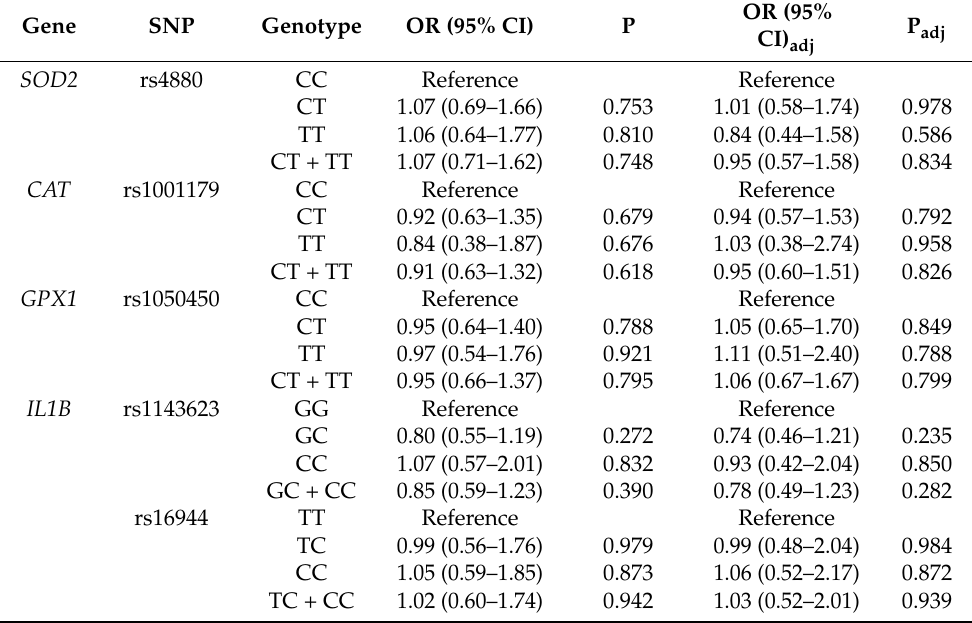
Table 2. Association between the investigated polymorphisms and ALS